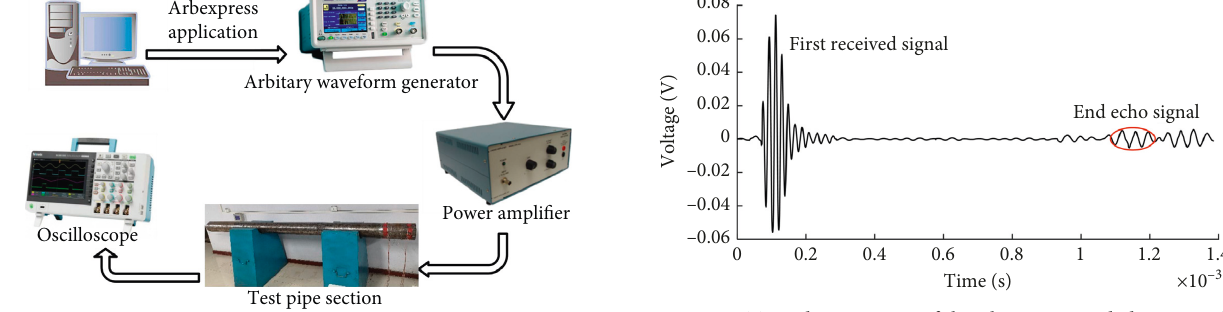
Figure 28: Acoustic emission test flowchart.